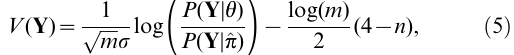
Figure S1 Computation of mutual exclusivity weight can be severely biased by errors in the data. Left plot: mutual exclusivity weight, proposed by Vandin and colleagues [4], for datasets simulated from the mutual exclusivity model without errors. In this case, the observed weight (weight computed on observed data) is the same as the true weight (weight computed on true data, i.e., with true alteration status recorded), and increases with coverage and decreases with impurity. Arrow points at one example pair of datasets, indicating how they are ranked by the true weight. Middle: addition of false negatives decreases the observed weight (here, computed on the observed, erroneous dataset, and not based on the true alteration status), but has a consistent effect and does not disturb the ranking. Right: addition of false positives has most severe effect on ranking using the observed weight. An arrow points at two datasets, which based on the true weight (i.e. computed on data recording true alteration status, as in the left plot) were ordered increasingly, and which are now reverse-ordered by the observed weight. Figure S2 Both our mutual exclusivity (ME) test and a permutation test, which was applied previously do not support mutual exclusivity in data generated from the independence model with independent frequencies distributed as in the glioblastoma dataset. Shown are log p-values for simulated data with 1000 patients, 20 datasets per each gene set size ( n [ f 3,5,10 g ). Figure S3 Imbalance of patterns identified with the ME approach is much lower than of patterns identified using the previously proposed weight. Box-plots summarize the imbalance distribution for 11 patterns called significant with ME p-value ƒ 0 : 05 , high coverage ( § 0 : 3 ) and low impurity ( ƒ 0 : 2 ; red), as well as the 10, 100, and 1000 top patterns with the largest weight, called significant with permutation test (p-value ƒ 0 : 05 ). Median imbalance of patterns prioritized using our approach is around three times lower than of patterns with top, significant weights, regardless of how many of the top ones are considered. Figure S4 Parameter estimation in the reduced mutual exclusivity model can be severely biased by errors in the data. Left column: the difference between the true and the estimated parameter values for datasets simulated from the mutual exclusivity model without errors. In this case, both impurity (delta; top) and coverage (gamma; bottom) estimation is very accurate, regardless the impurity (marked with colors). The true coverage values are indicated on the x-axis. Middle column: addition of false negatives results in underestimation of the coverage parameter. Right column: addition of false positives results in underestimation of both the impurity and coverage parameters, and most strongly affects estimation of low coverage values. Figure S5 Efficient parameter estimation of the cover- age parameter c and the impurity parameter d , using